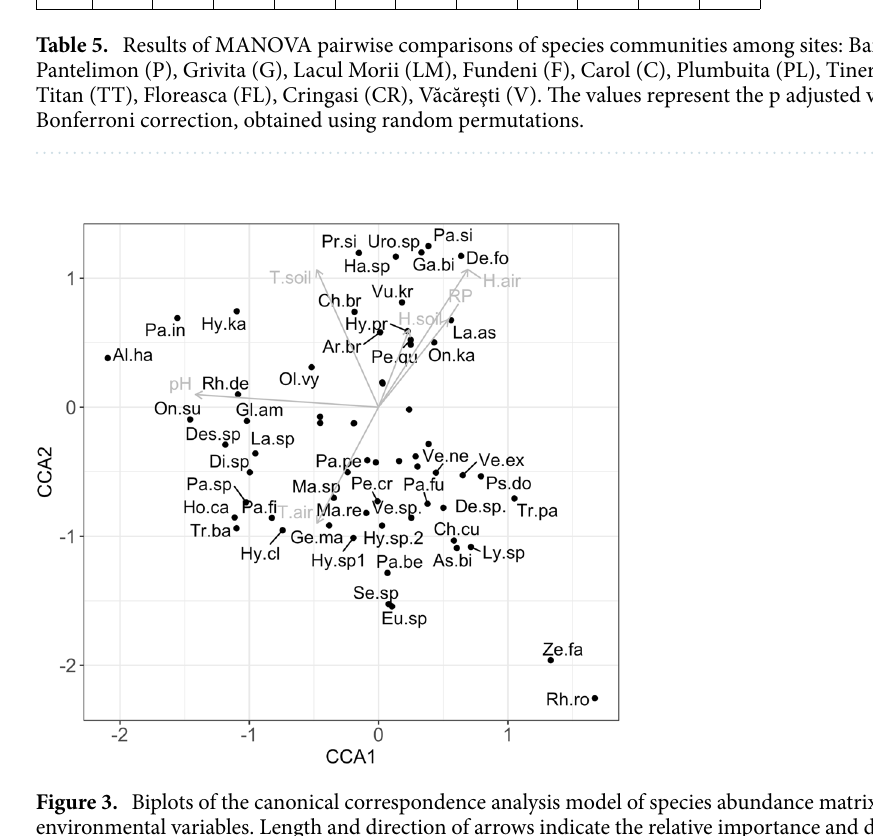
Based on species richness, the model selection using AICc indicated one highly supported model that included the pH (Table 6). The second best supported model included the MS. Species richness significantly increased with pH ( F [1,231] = 4.00, p = 0.04) for all management scenarios (Fig. 4). No significant differences in species richness were found among the UGA ( F [2,106] = 0.9, p = 0.533). Focussing on individual Bucharest parks, the highest number of identified species and number of individu- als was recorded in TN park (17 species with 157 individuals), in comparison with V, CL or FL, PL areas, where the values were lowest (number of species between 8 and 10 and number of individuals between 25 and 50 individuals). These results are confirmed by the Shannon index of diversity, which had the highest value in TN